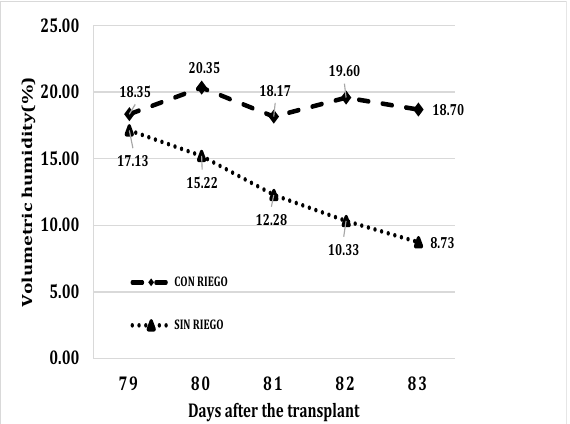
Figure 1: Variation of volumetric humidity of substrate during the fourth cycle of humidity Table 1. Averages and statistical significance of the differences in characteristics of native potato plants grown in continuous irrigation (CI) and restricted irrigation (RI) conditions Characteristics